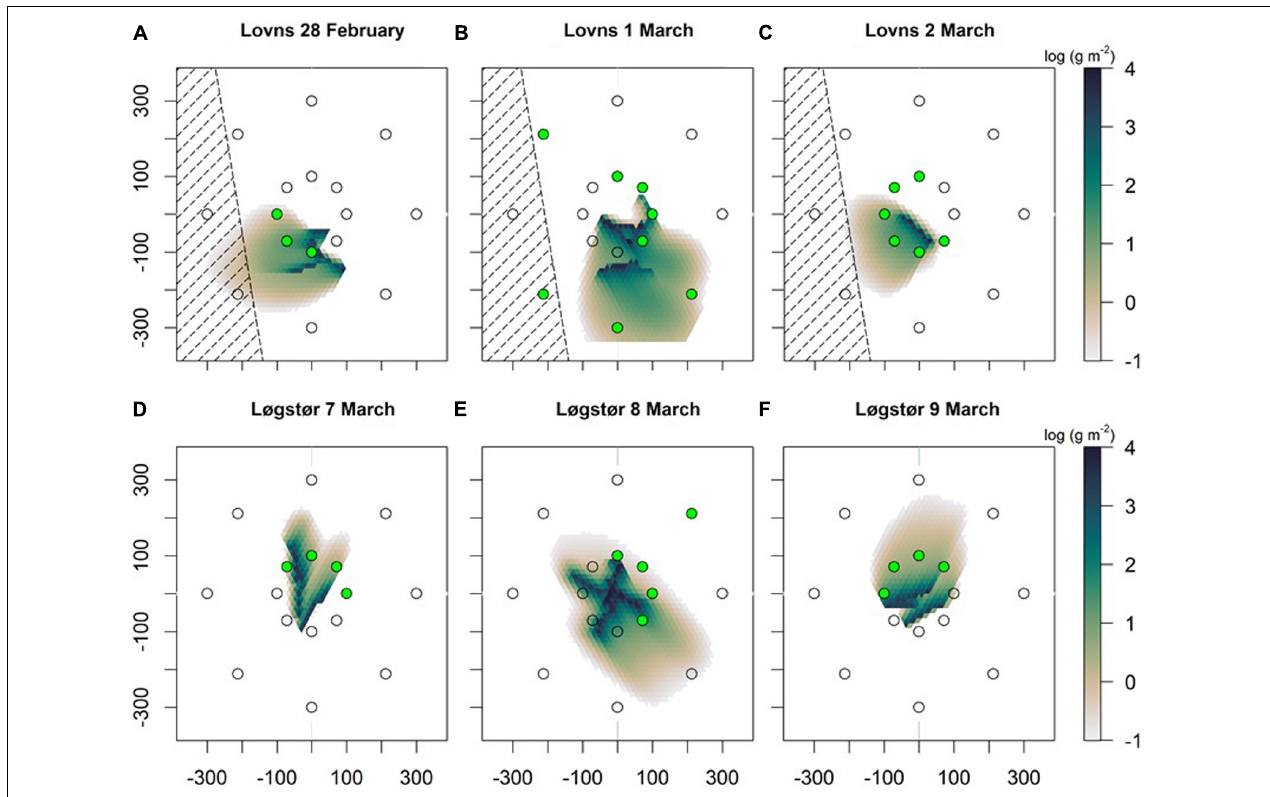
FIGURE 5 | Accumulated sediment concentration (g m - 2 on log scale) at the end of the trawling activities in Lovns Bredning on three dates: (A) 28 February, (B) 01 March, and (C) 02 March and in Løgstør Bredning for three dates: (D) 07 March, (E) 08 March, and (F) 09 March. The hatched area indicates the location of the eelgrass box. Black circles indicate the position of loggers and filled green circles are the estimated light intensity anomalies from Figure 4 .